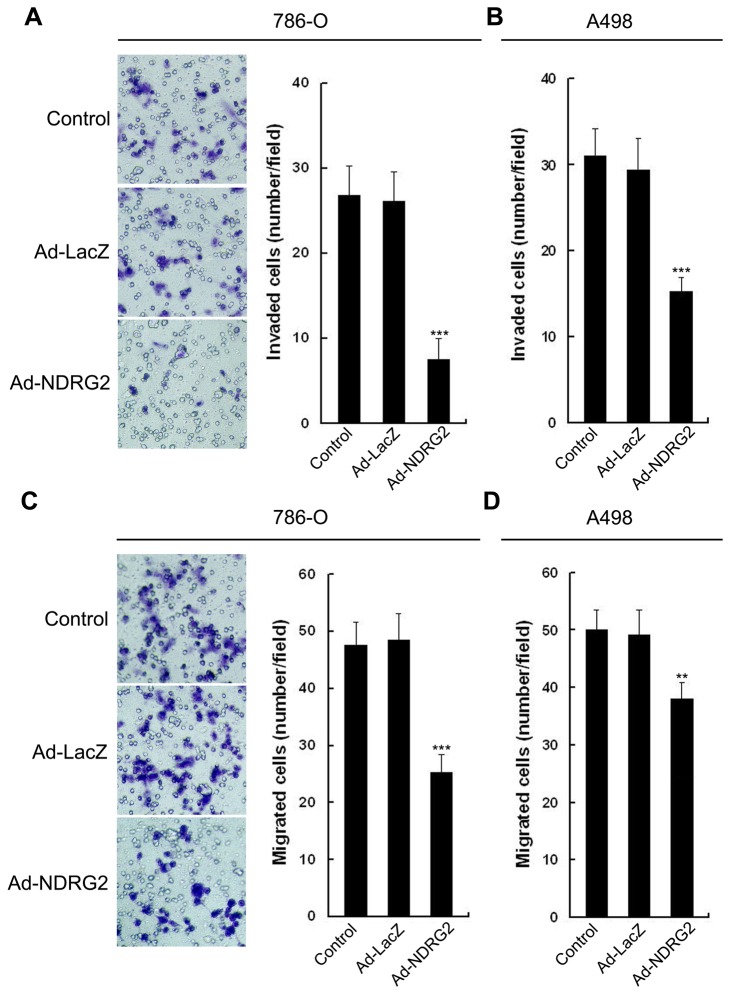
Effect of NDRG2 on invasion and migration of renal cancer cells.(A and B) The invasion ability was estimated using Transwell coated with Matrigel. The amount of invaded cells was calculated in five random high-power fields (400×magnification). The histogram represents the quantification of cells that invaded. (C and D) The migration ability was estimated using Transwell uncoated with Matrigel. The amount of migrated cells was calculated in five random high-power fields (400× magnification). The histogram represents the quantification of cells that migrated. The data are the mean ± standard deviation (SD) for three independent experiments. Statistical significance was assessed using one-way ANOVA. ** or *** indicates P < 0.01 or P < 0.001, respectively, when compared with the Ad-LacZ group.